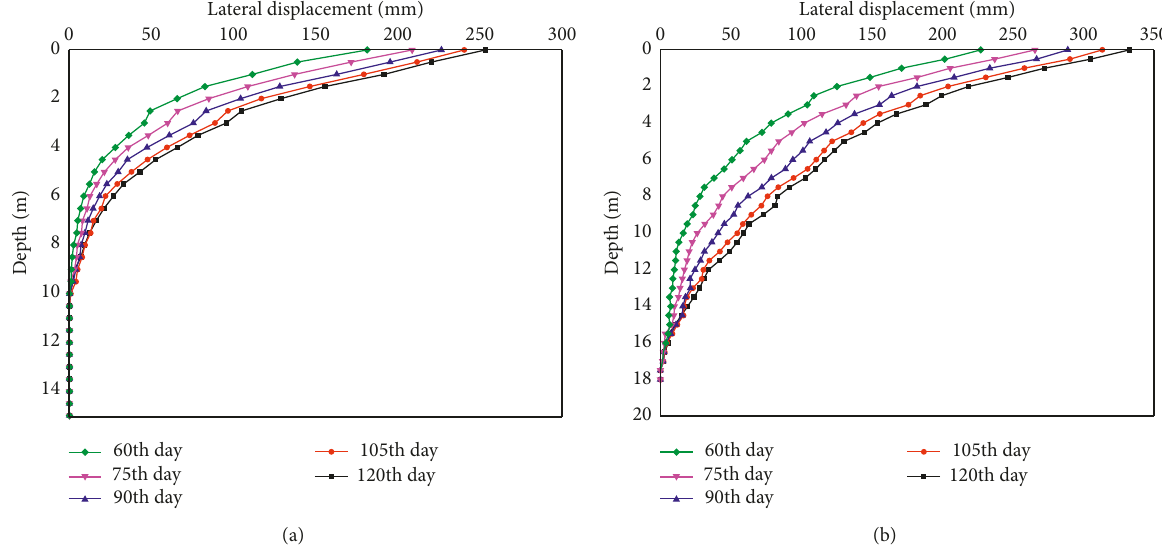
Figure 13: Lateral displacements plotted as functions of time for sections (a) 1 and (b)